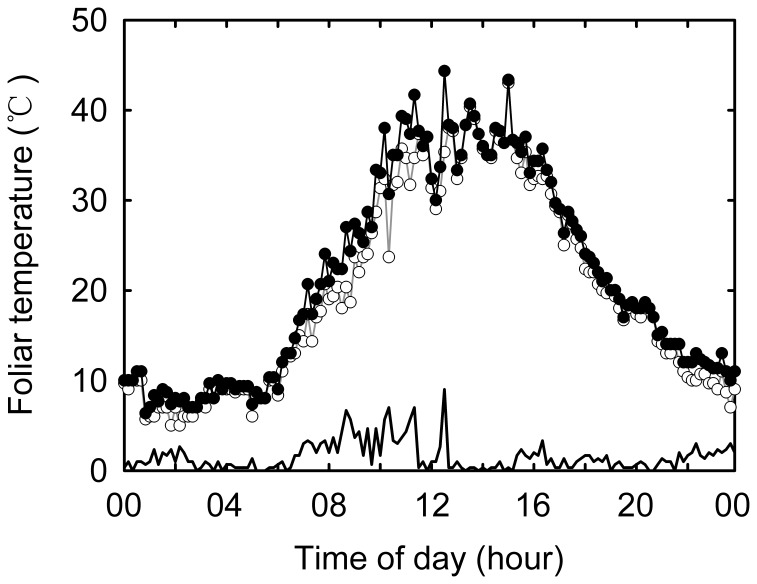
Representative 24-h foliar temperature (T
leaf) profiles from Stipa krylovii Roshev. grown in the control (open) and warming (filled) plots during the field measurement campaigns.Thick solid line indicates warming-induced changes in T
leaf between control and warming plots.